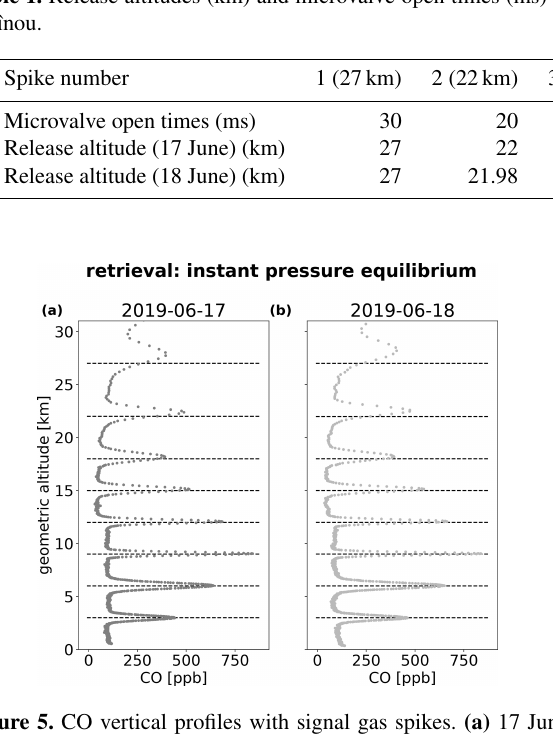
Figure 5. CO vertical profiles with signal gas spikes. (a) 17 June and (b) 18 June, Traînou, 2019. The dashed lines indicate the signal release GPS altitudes. CO measurements are attributed to geometric retrieval altitudes assuming an instantaneous pressure equilibrium between AirCore and ambient air during